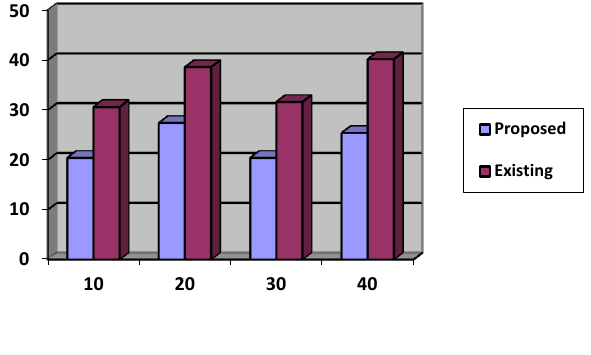
Figure 6. Average Energy Consumption